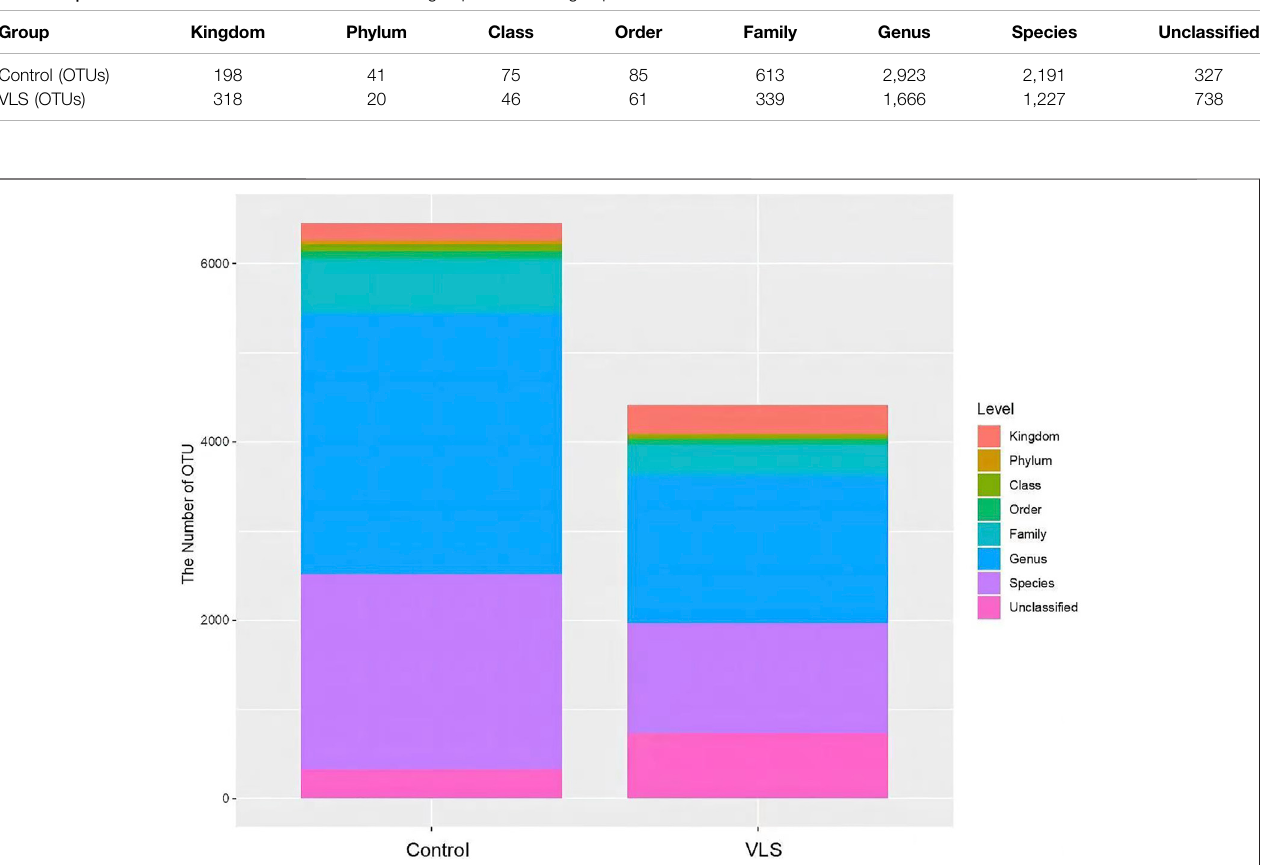
FIGURE 1 | Comparison of OTU numbers at all levels between the VLS group and control group.